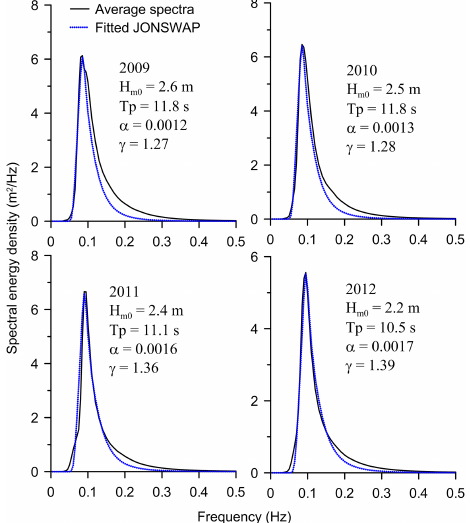
Figure 10. Averaged wave spectra for waves with significant wave height more than 2m and the fitted JONSWAP spectra for different